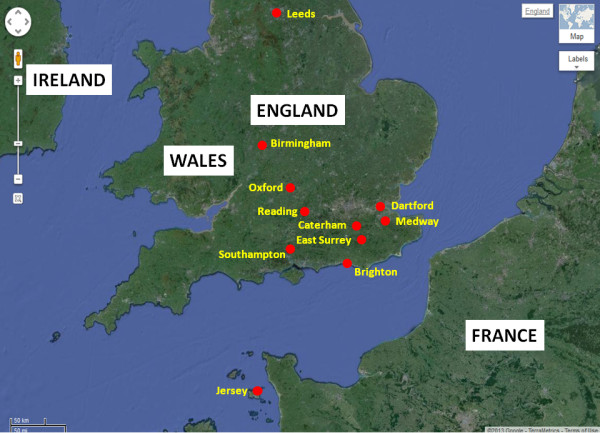
Norovirus epidemiology and sampling frame. Locations from which samples were obtained with England and Jersey (map courtesy of Google map).